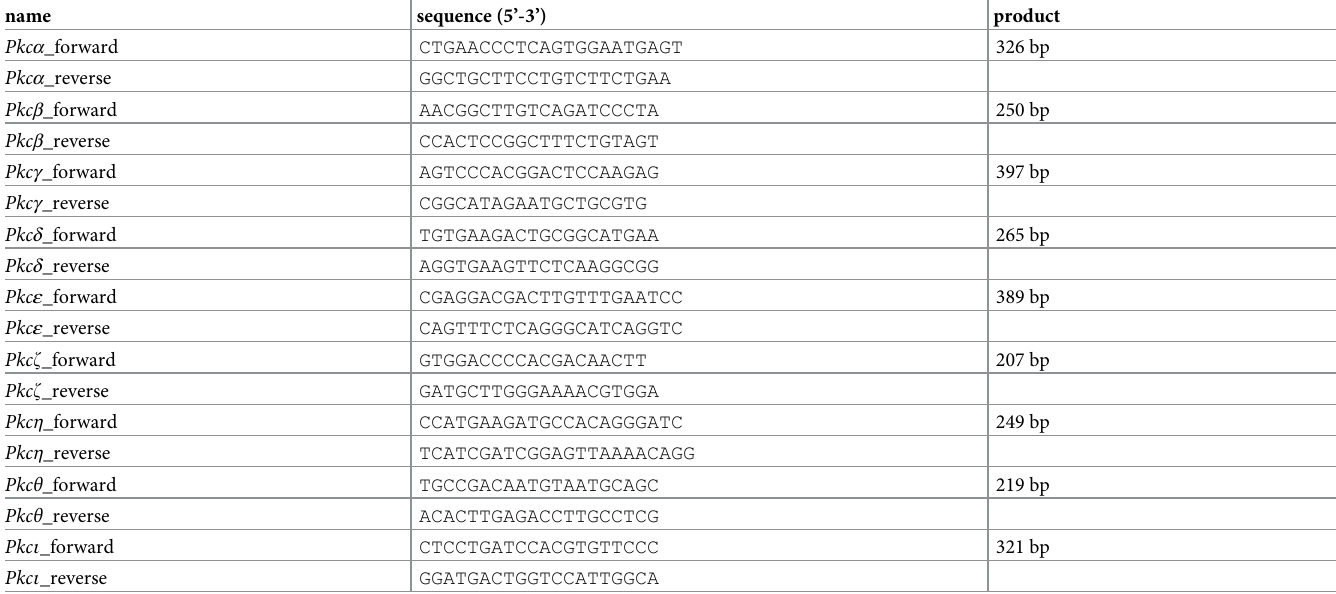
Table 1. Primer sequences used for expression